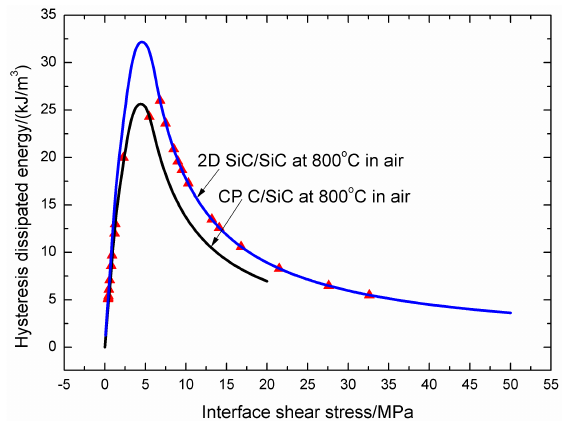
Figure 19. The experimental and theoretical fatigue hysteresis dissipated energy of cross-ply C/SiC and 2D woven SiC/SiC composites at 800 °C in air.